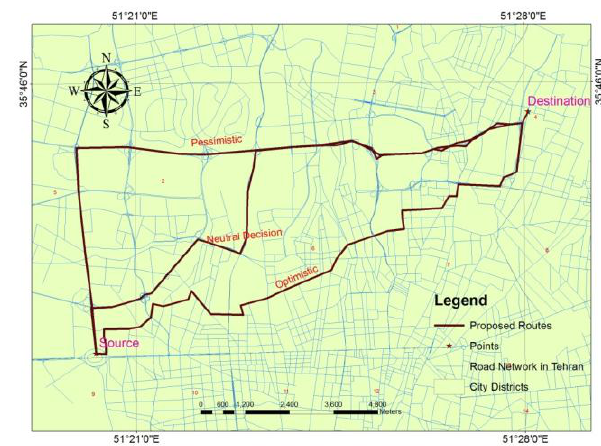
Figure 8. The influence of optimism degree on route